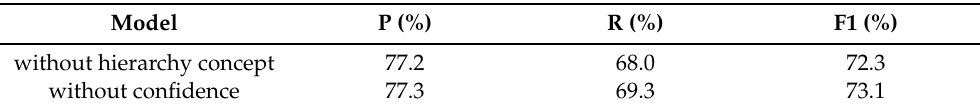
Table 5. Performance of framework without hierarchy concept and hierarchy concept confidence. Model